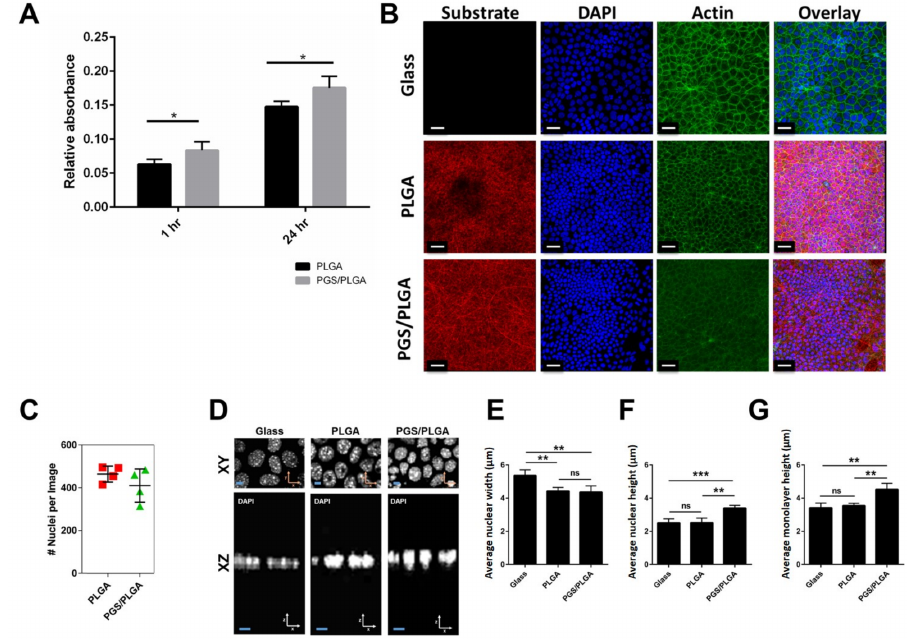
Figure 4. Softer PGS/PLGA scaffolds affect SIMS cell morphology. ( A ) MTT assay showing SIMS cells on PLGA and PGS/PLGA nanofiber scaffolds. Data are means ± SD ( n = 5) * p < 0.05 unpaired t -test, ( B ) Maximum projection images of SIMS cell morphology following culture on Glass, PLGA or PGS/PLGA scaffolds (red) for 7 days. ICC: actin (phalloidin, green), DAPI (blue). Scale bar, 30 µ m, ( C ) Number of nuclei per image for cells grown on PLGA and PGS/PLGA scaffolds quantified from confocal Z-stacks with BioLIME, ( D ) Zoomed in single XY and XZ images of nuclei stained with DAPI for cells cultured on the three substrates for 7 days. Scale bar, 2 µ m. Quantification of ( E ) average nuclear width, ( F ) average nuclear height, ( G ) average monolayer height obtained with BioLIME. Data are means ± SD ( n = 4). NS: not significant, * p < 0.05, ** p < 0.01, *** p <